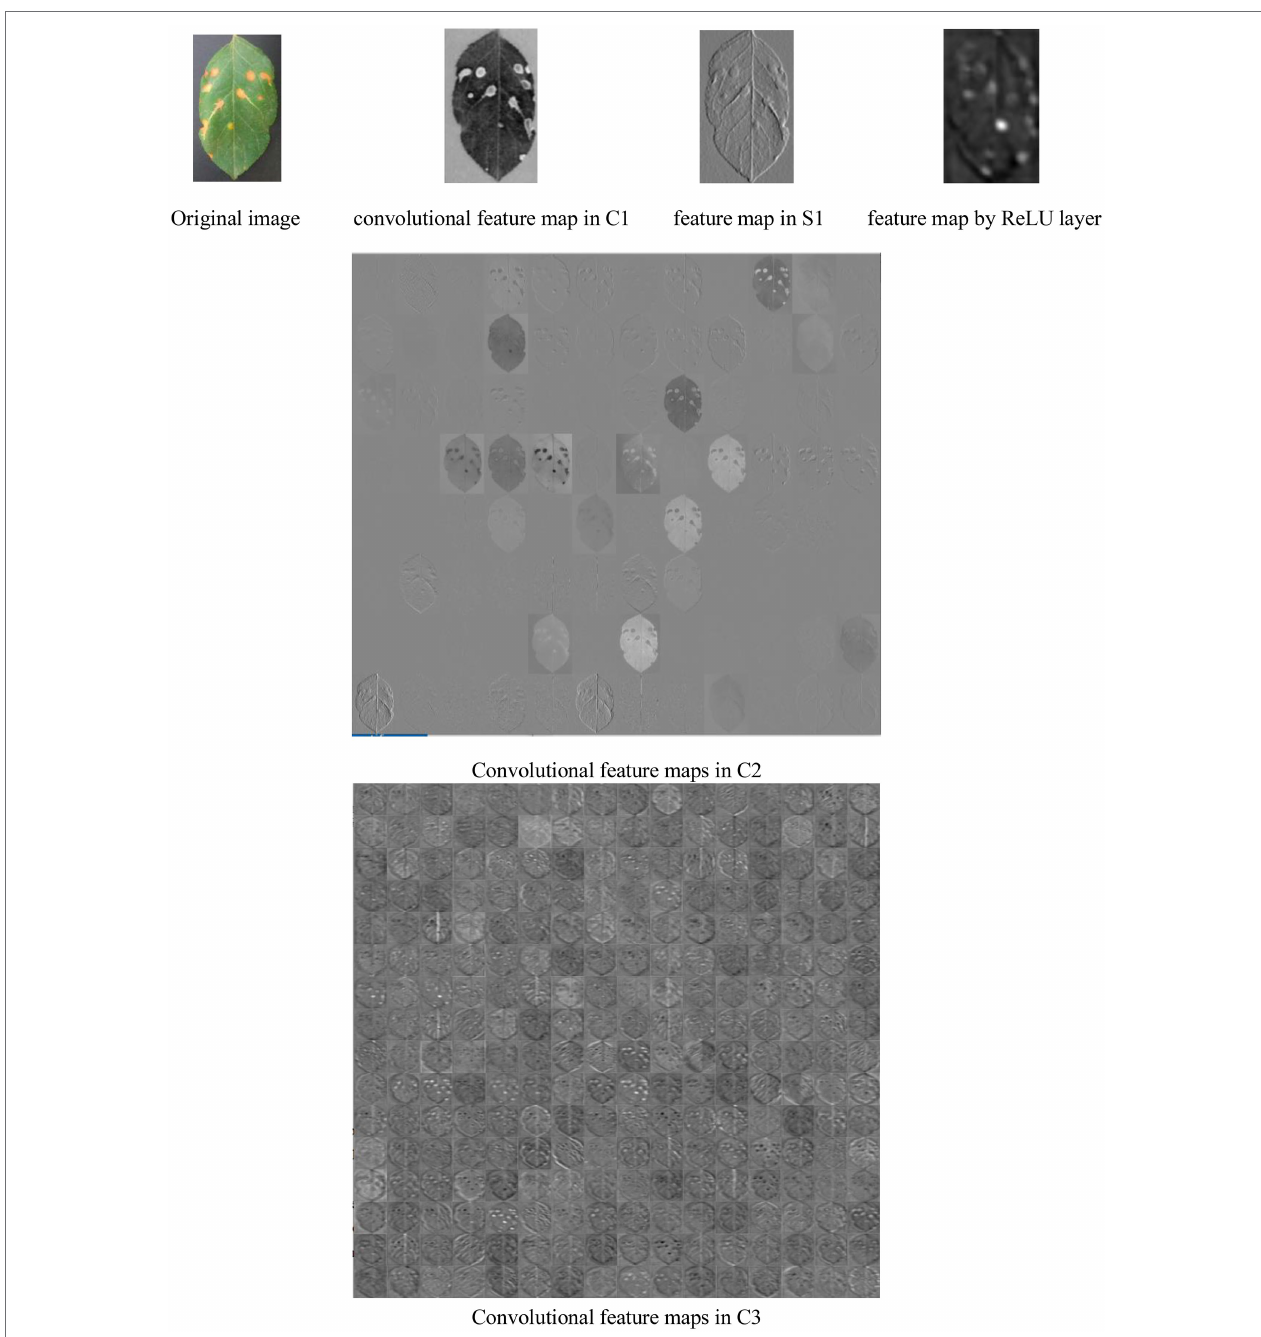
FIGURE 8 | Feature images of a diseased RGB image in different